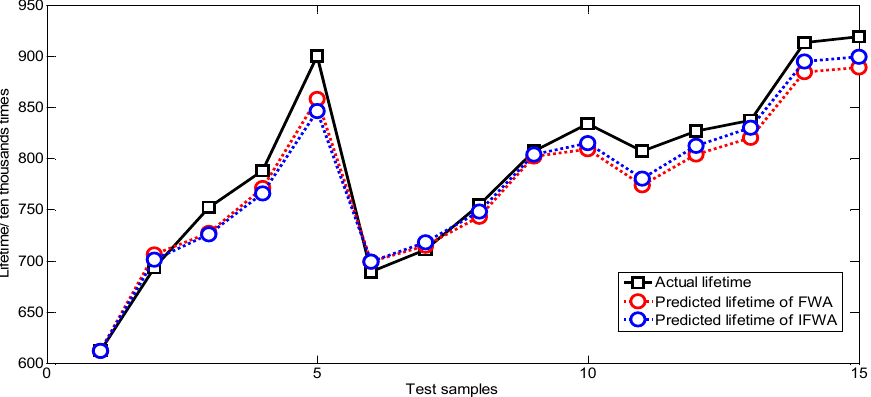
Figure 9. The comparison of actual results and prediction results using two models.